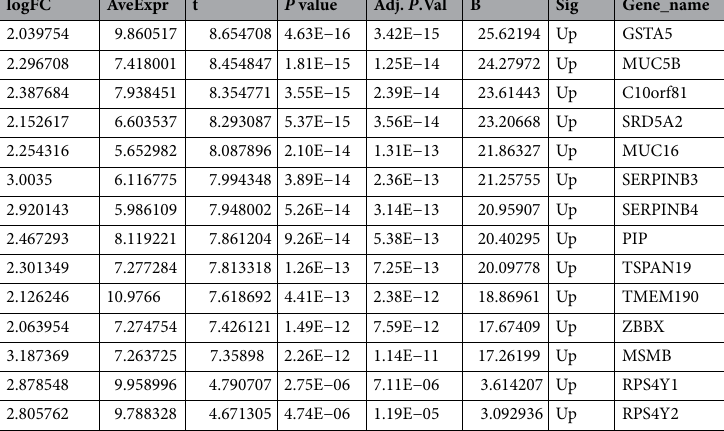
Table 1.. 126 DEGs from GSE47460.